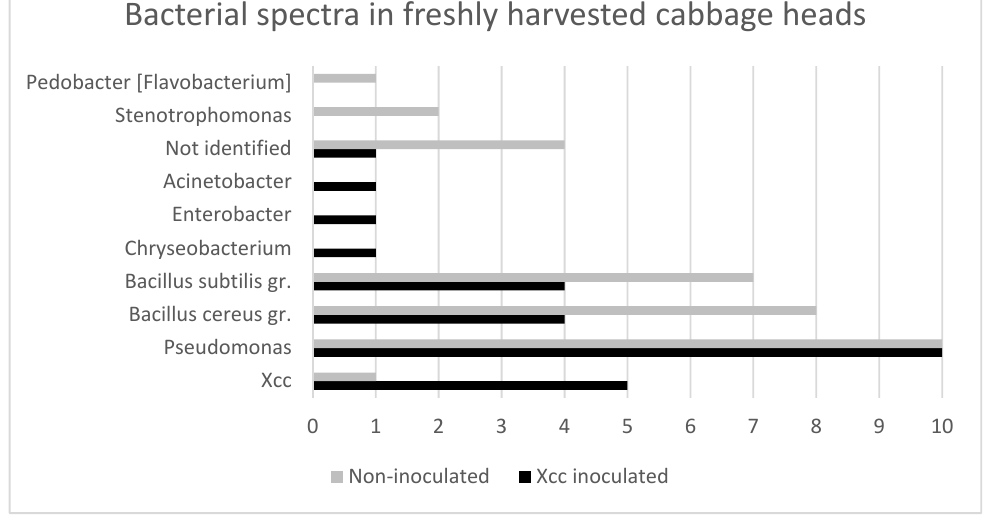
Figure 2. The number of cabbage heads from the sampling at the day of harvest of Xcc-inoculated and non-inoculated cabbage heads with positive detection of the bacterial genera.